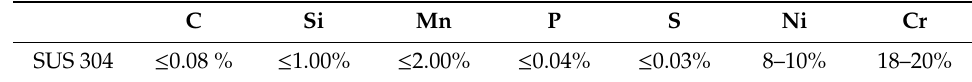
Table 1. Chemical composition of SUS304.